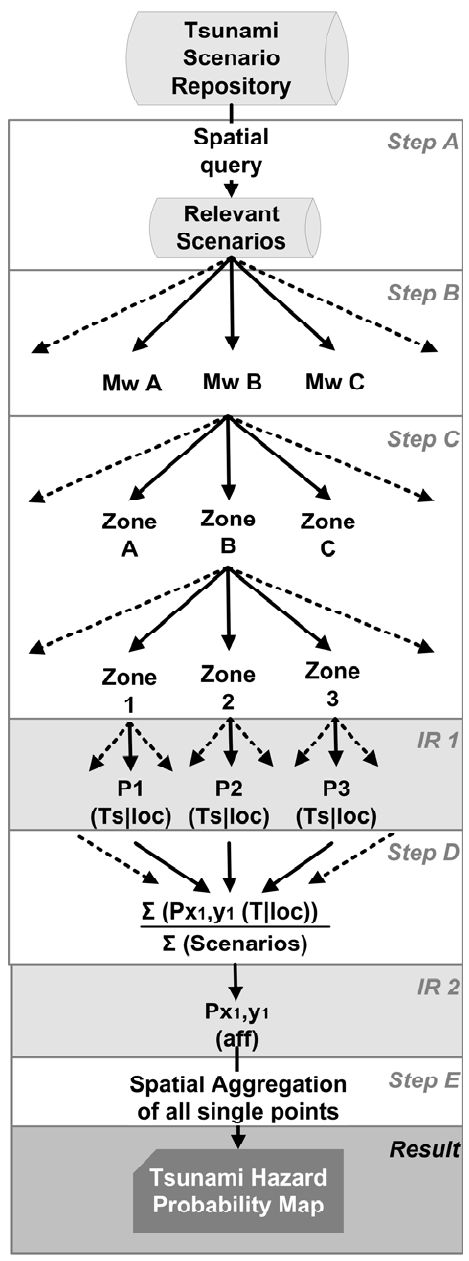
Fig. 5. Principle scheme for the aggregation of various scenarios and their probabilities in the multi-scenario